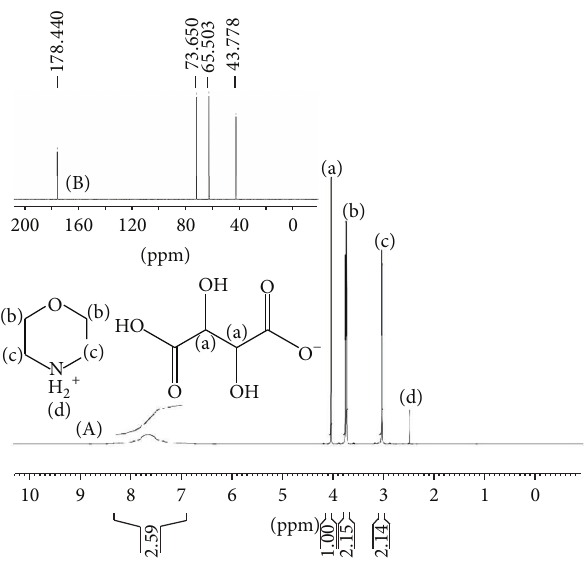
Figure 3: (A) 1 H and (B) 13 C NMR spectrum of